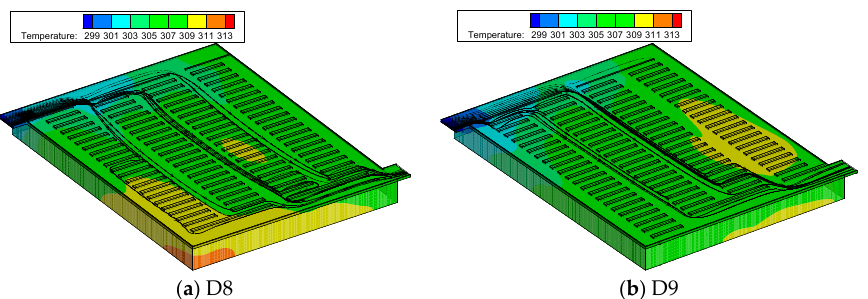
Figure 7. Temperature contours with superimposed streamline at t = 1080 s for Z-type parallel chan- nel cold plates.